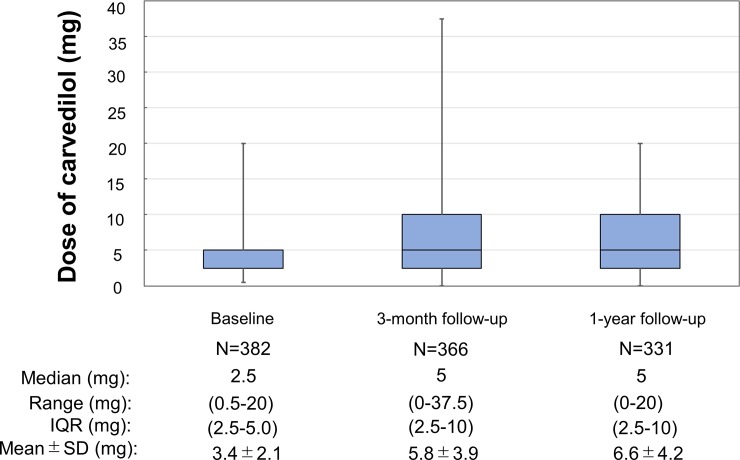
Dose of carvedilol at each follow-up.Among 394 patients in the carvedilol group, 12 patients did not receive the assigned carvedilol treatment; prescription of bisoprolol in 7 patients and no prescription of beta-blocker in 5 patients (protocol violation).